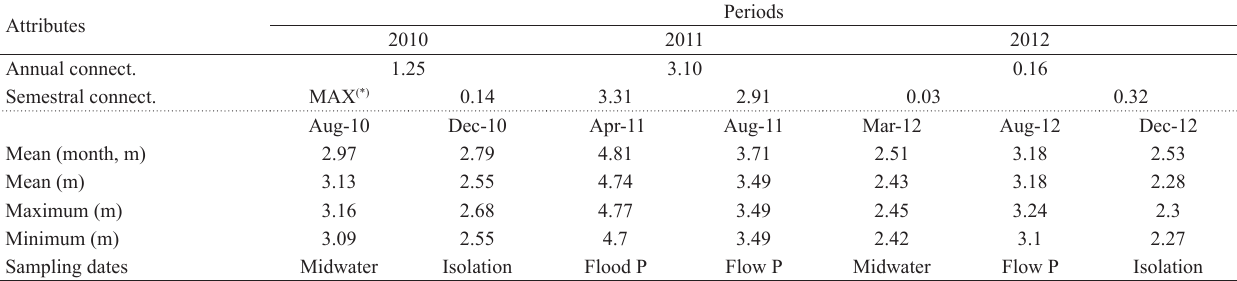
Tab. 1. Values of hydrological attributes in the area of study by sampling date from 2010 to 2012 (Isolation < 2.3 m; Midwater: between 2.3 and 3.2 m; Flow P=Flow pulse: between 3.2 and 4.5 m; Flood P=Flood pulse > 4.5 m). (*) There were no days with water levels lower than 3.2 m in the first half of 2010. Thus, it is not possible to obtain a quantitative value with the expression used for the computation of connectivity but it was the maximum through the entire period of